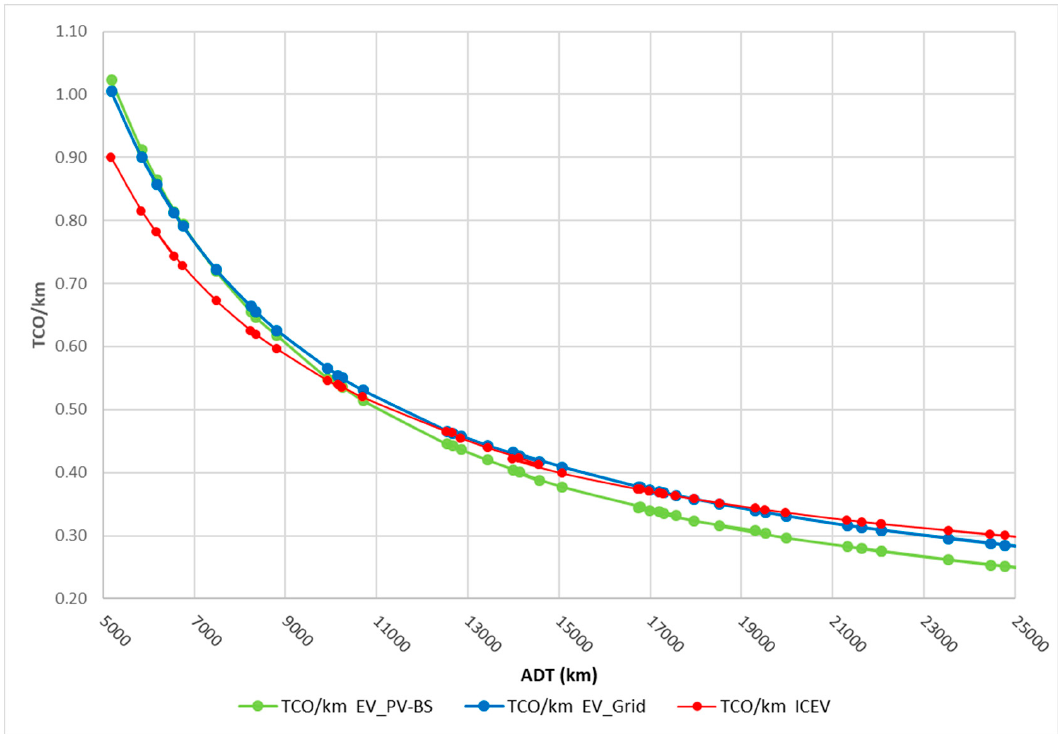
Figure 5. TCO/km in the base-case scenario with varying ADT. Figure 5. TCO / km in the base-case scenario with varying